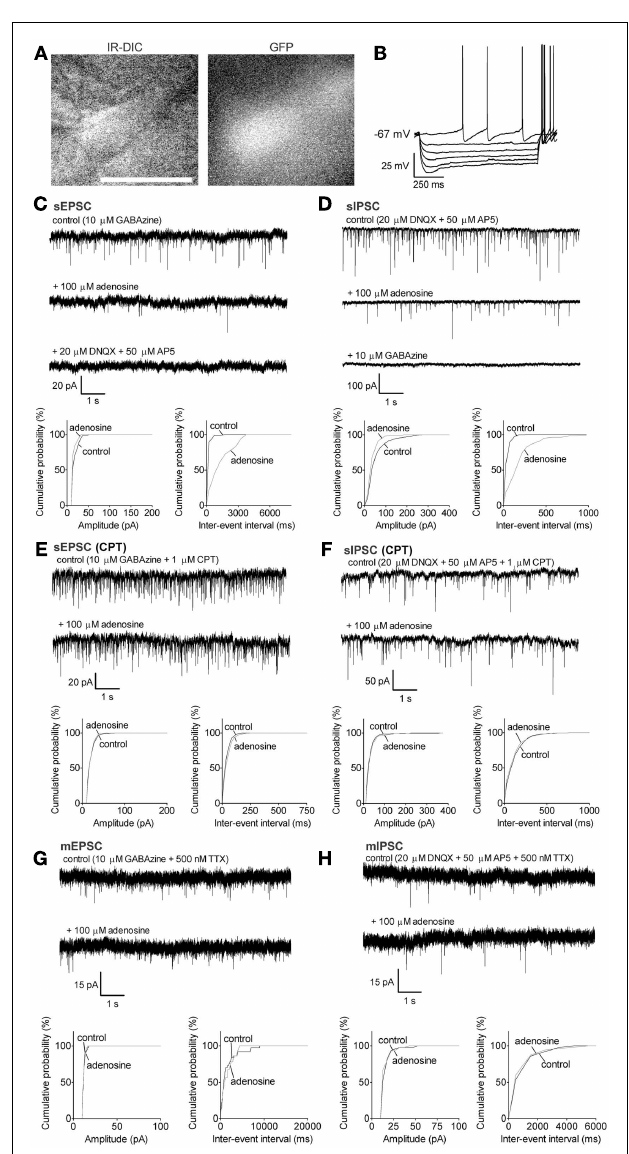
FIGURE 3 |Adenosine significantly decreases the frequency of sEPSC and sIPSC viaA1 receptors GABAergic neurons with a small I h . (A) Infrared-differential interference microscopy (IR-DIC) and black-and-white fluorescent images of a typical GABAergic neuron with a small I h . Scale bar: 25 µ m. GABAergic neurons were distinguished from cholinergic neurons by their GFP-positive pattern under fluorescent illumination and identified by their typical intrinsic membrane properties during current pulses (B) − 300 to 0, − 60pA interval. GABAergic neurons with a small I h were spontaneously active, and exhibited small depolarizing sags during hyperpolarizing current pulses and small afterhyperpolarizations when depolarized. (C) Adenosine reduced the frequency but not the amplitude of spontaneous excitatory postsynaptic currents (sEPSC).The GABA A receptor antagonist, GABAzine, was used to isolate excitatory events. Holding potential was − 60mV. (D) Adenosine reduced the frequency but not the amplitude of spontaneous inhibitory postsynaptic currents (sIPSC).The ionotropic glutamate receptor antagonists, DNQX and AP5 were used to isolate inhibitory synaptic events. A KCl-based intracellular solution and a holding potential of − 90mV were used to enhance the driving force